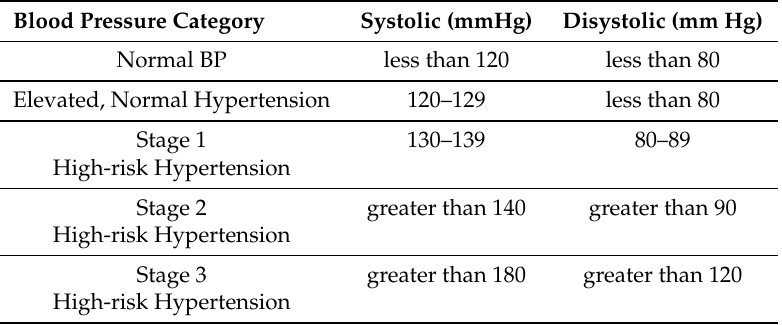
Table 1. Typical blood pressure ranges